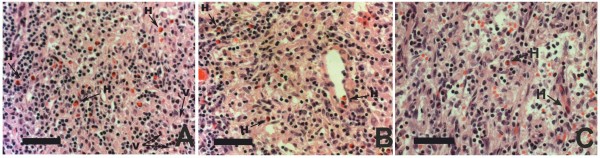
Sinus histiocytosis. A. Histiocytes in the central sinuses of the lymph node after six months exposure to MgCa0.8 (H&E, × 400). Note the histiocytes with non-stained vacuoles (V) and the diffuse heterophilic infiltration (H). B. H&E staining after six months exposure to TiAl6V4 (H&E, × 400). Heterophilic infiltration is present (H) but no vacuoles could be observed. C. Physiological lymph node (control group without surgery, H&E staining, × 400). Black bar = 50 μm.